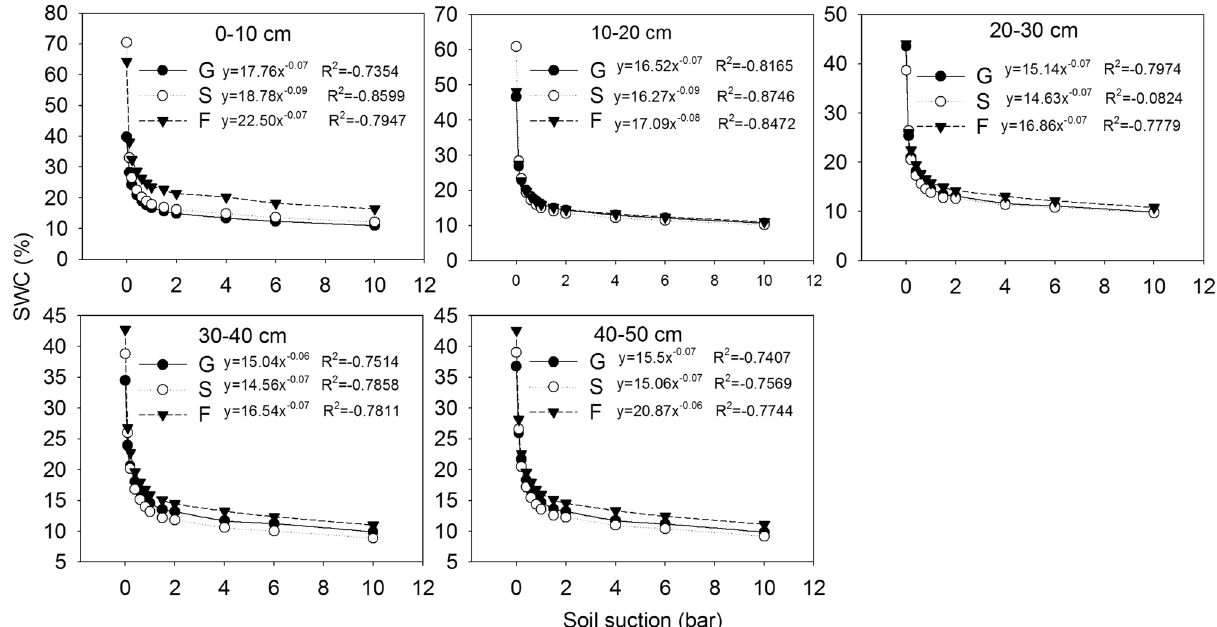
Figure 3. Soil water characteristic curves at different soil depths (0–10 cm, 10–20 cm, 20–30 cm, 30–40 cm and 40–50 cm) at different vegetation restoration stages. G, S and W are defined as in Table